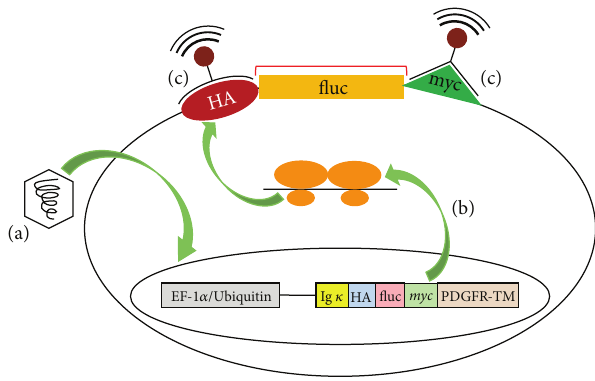
Figure 6: Mechanism of genetic manipulation of ESCs. HA, myc, and FLUC genes integrated into (a) the genome of ESCs and (b) coexpressed on the cell surface. SPIO conjugated monoclonal antibody specifically targets the antigens expressed on the cell surface, reproduced with permission from reference